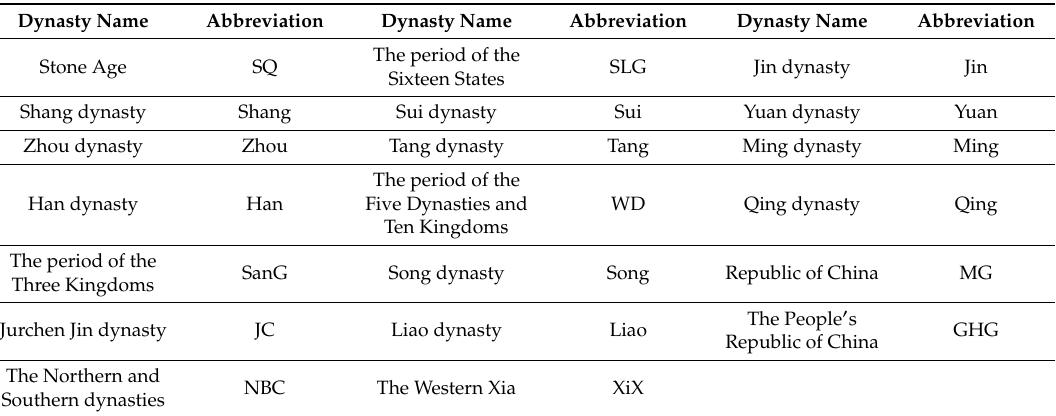
Table A1. Abbreviation of dynasty